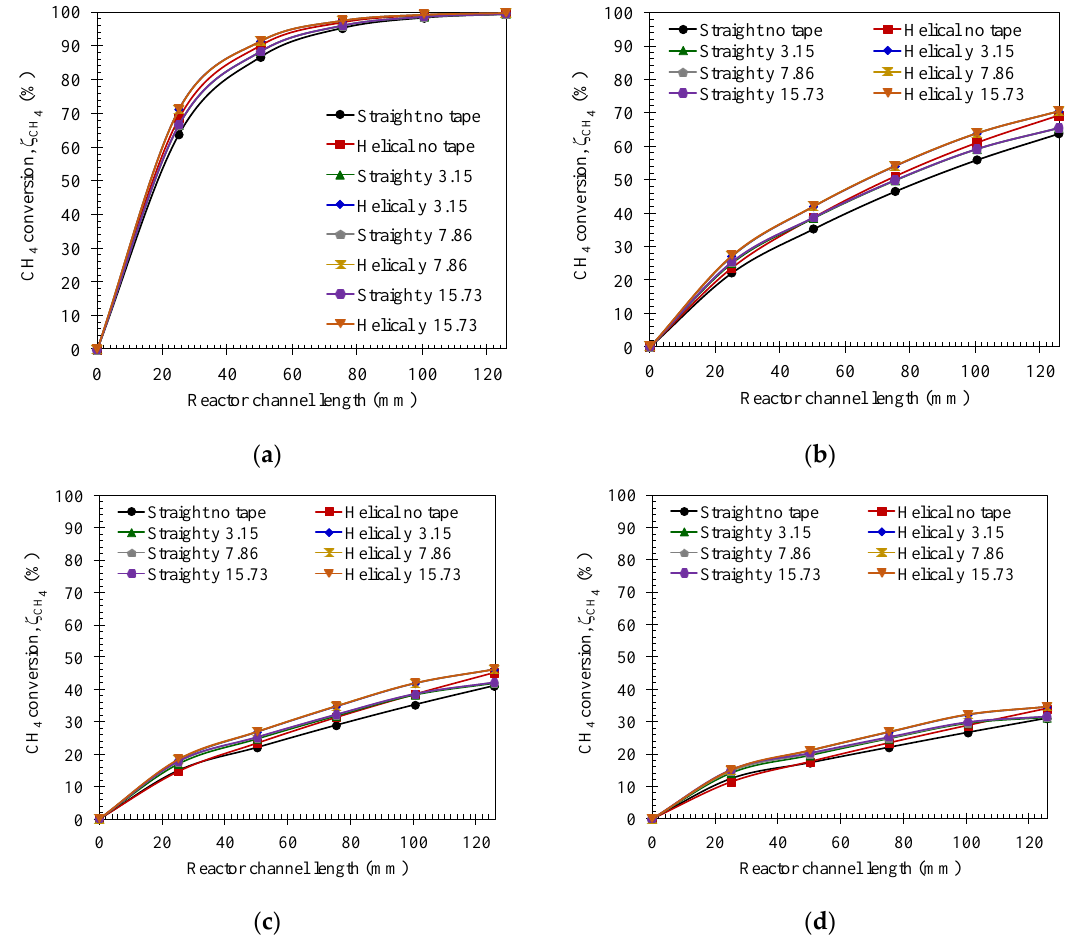
Figure 4. Methane conversion along the straight and helical reactor at Reynolds number of ( a ) 100, ( b ) 500, ( c ) 1000, and ( d ) 1500.